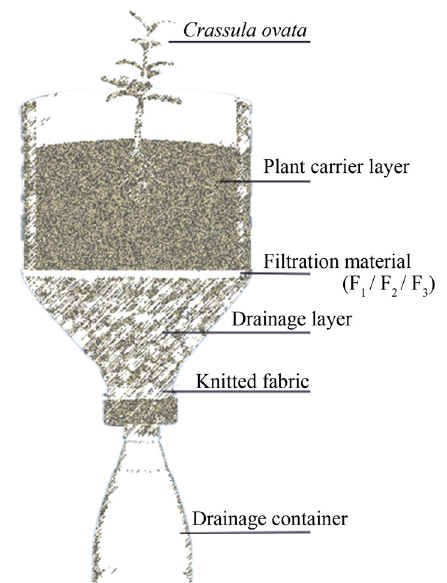
Figure 2. Cross-section of the pot used in the